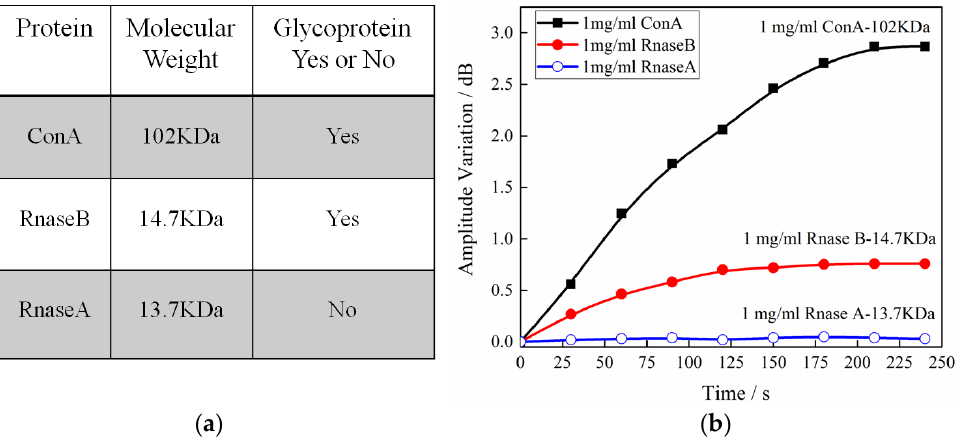
Figure 6. ( a ) Proteins that we have chosen in our experiment, Con A and Rnase B are glycoprotein, while the Rnase A and BSA are non-glycoprotein, all of these are to evaluate the selectivity of the biosensor. ( b ) The corresponding data analysis to monitor of different kinds of proteins via the developed TFBG-based sensor. The amplitude sensitivity was 2.867 dB/(mg/mL), 0.76 dB/(mg/mL), and 0.03 dB/(mg/mL).